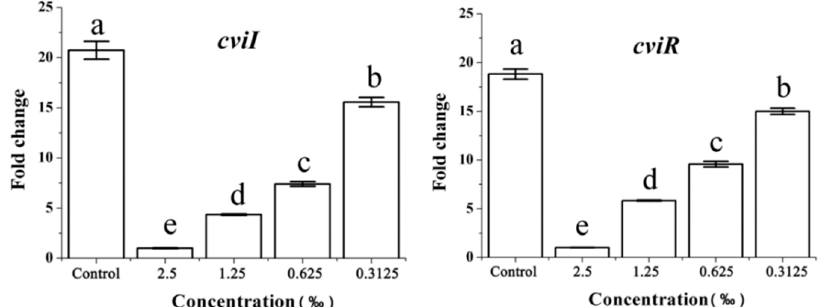
Figure 7. Effect of C. camphora EO on the expression of cviI and cviR . Quantitative RT-qPCR of the cviI and cviR genes. Expression of the housekeeping gene, rpoD , was used as the internal control for each sample. Bars indicate standard errors and different letters ( a – e ) above the bars represent significant differences ( p < 0.05).